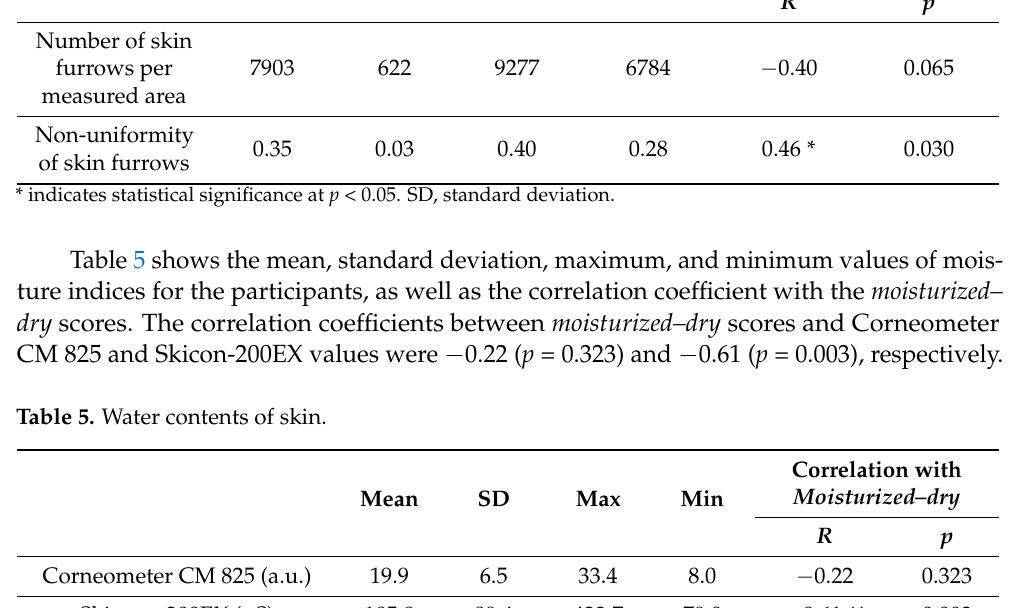
Table 4. Results of skin furrow measurements. Mean SD Max Min 7903 622